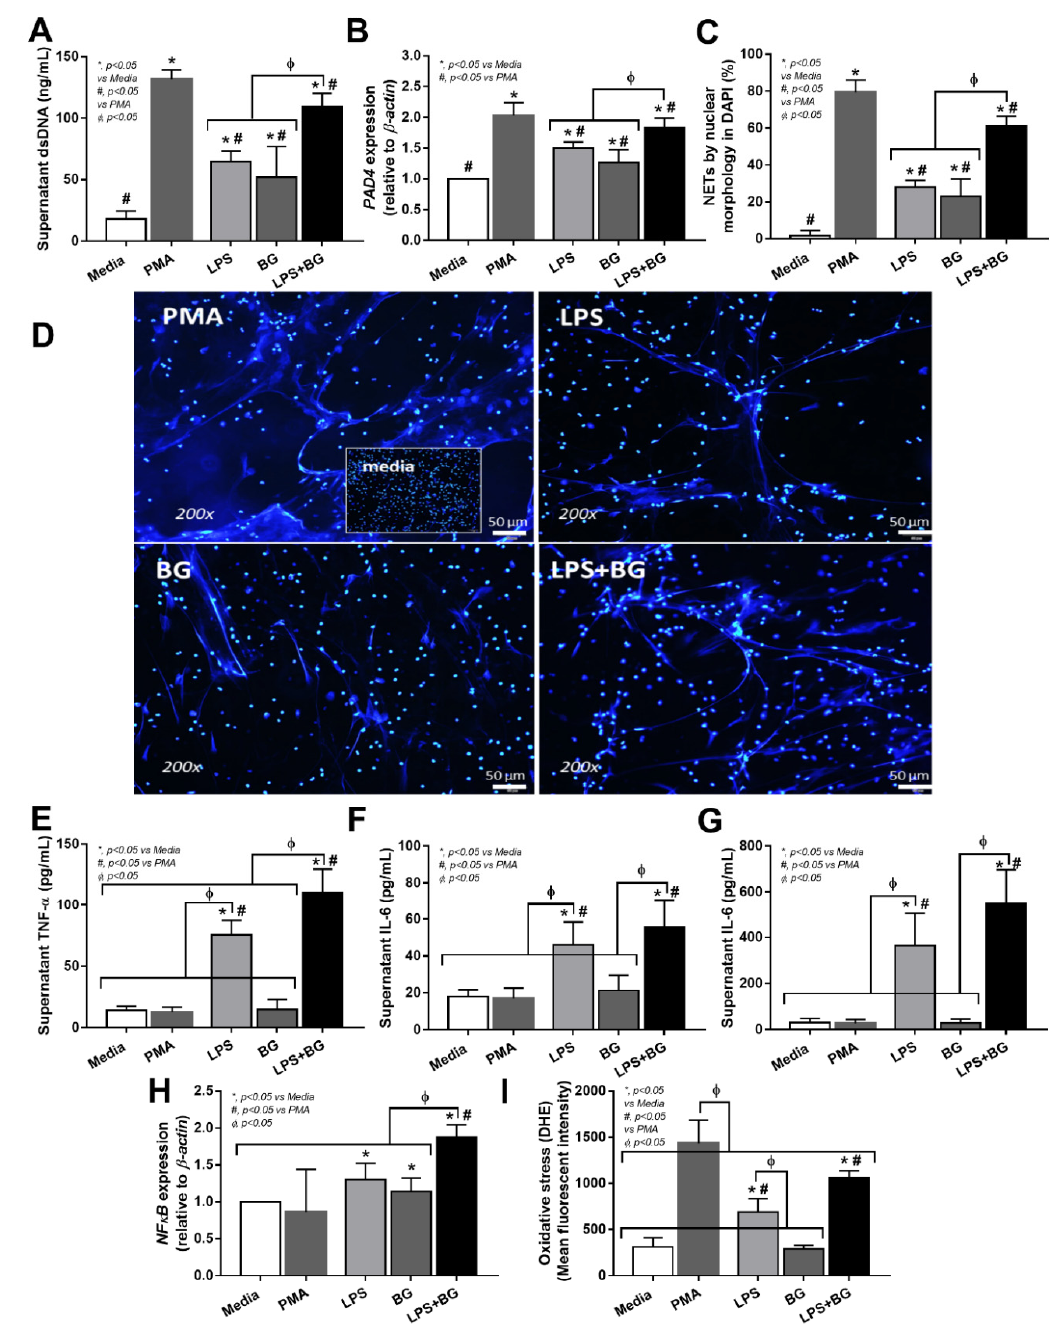
Figure 6. Neutrophil extracellular traps (NETs) of the isolated neutrophils from healthy volunteers after activation by control serum, lipopolysaccharide (LPS) with and without (1 → 3)- β -D-glucan (BG), using Phorbol 12-myristate 13-acetate (PMA) as a positive control of NETs inducers, as indicated by supernatant dsDNA ( A ), Peptidyl Arginine Deiminase 4 ( PAD-4 ) expression ( B ), morphology of DAPI nuclear staining with the representative pictures ( C , D ), supernatant cytokines ( E – G ), nuclear factor kappa B ( NF κ B ) expression ( H ), and reactive oxygen species (ROS) using dihydroethidium (DHE) ( I ) (neutrophils were isolated from 7 volunteers and each groups of neutrophils were used in all group of activations). * p < 0.05 vs internal serum control groups, Φ p < 0.05 between the indicated groups and # p < 0.05 vs PMAas determined by ANOVA with Tukey’s analysis.